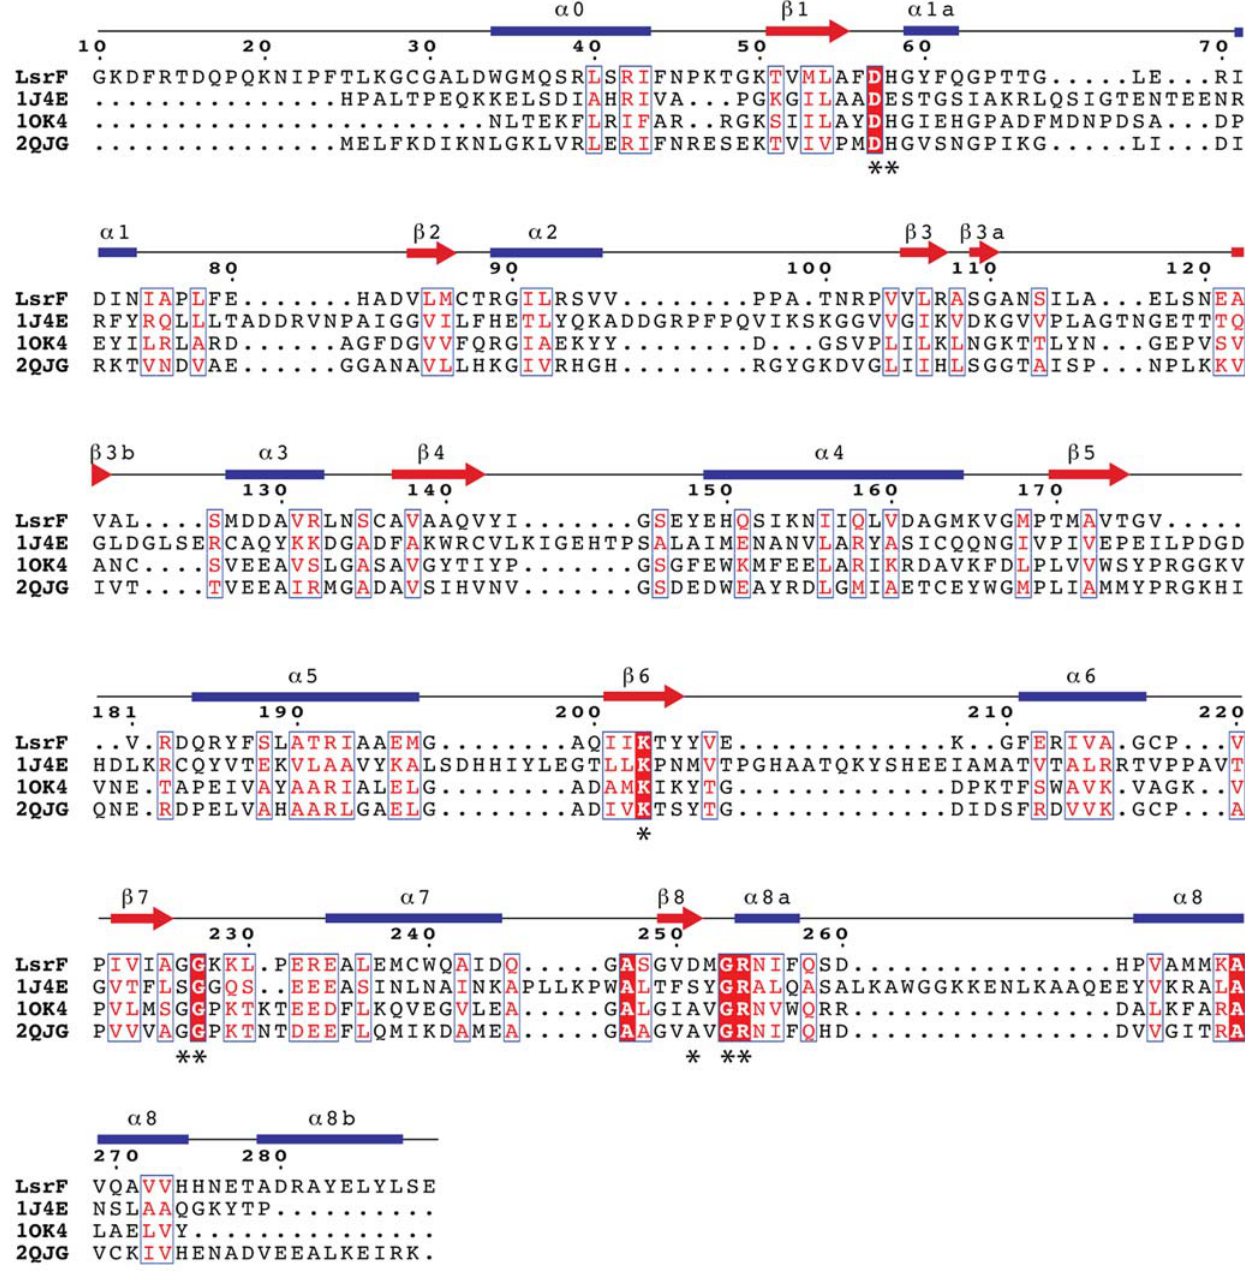
Figure 4. Structure-based sequence alignment highlights conservation of binding-site and potential catalytic residues. Structure- based alignments [47] were calculated for LsrF with rabbit FBPA (1J4E), T. tenax FBPA (1OK4), and M. jannaschii ADH synthase (2QJG). Identical residues are in white on red, conserved residues are in red (boxed). Secondary structure (from LsrF) is indicated above the sequence: blue bars are a -helices and red arrows are b -sheets. Residues implicated as either hydrogen bonding to the ligand phosphate or catalytic are indicated with an asterisk; these residues are disproportionately conserved. Numbering follows the LsrF sequence.